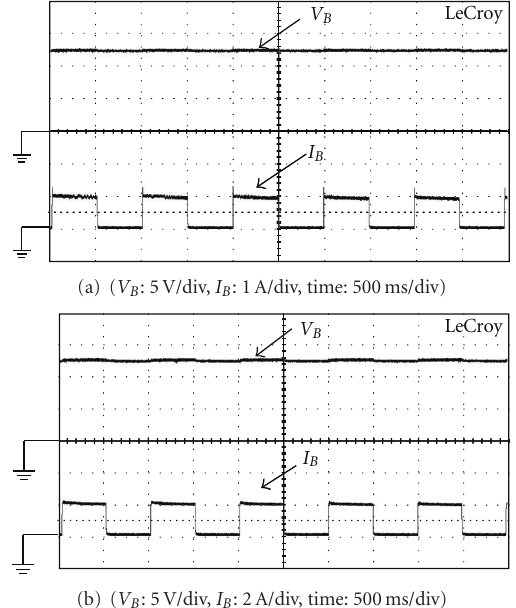
Figure 20: Measured waveforms of battery voltage V B and charging current I B with pulse current charging method: (a) I B (max) = 1A and (b) I B (max) =